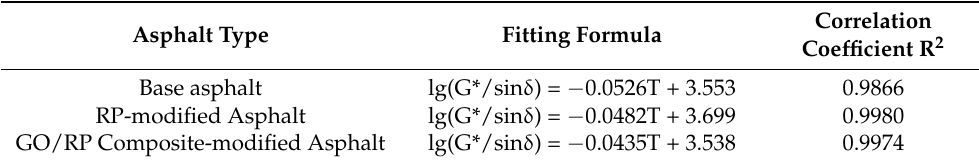
Table 3. Fitting table of rutting factor temperature curve of three kinds of